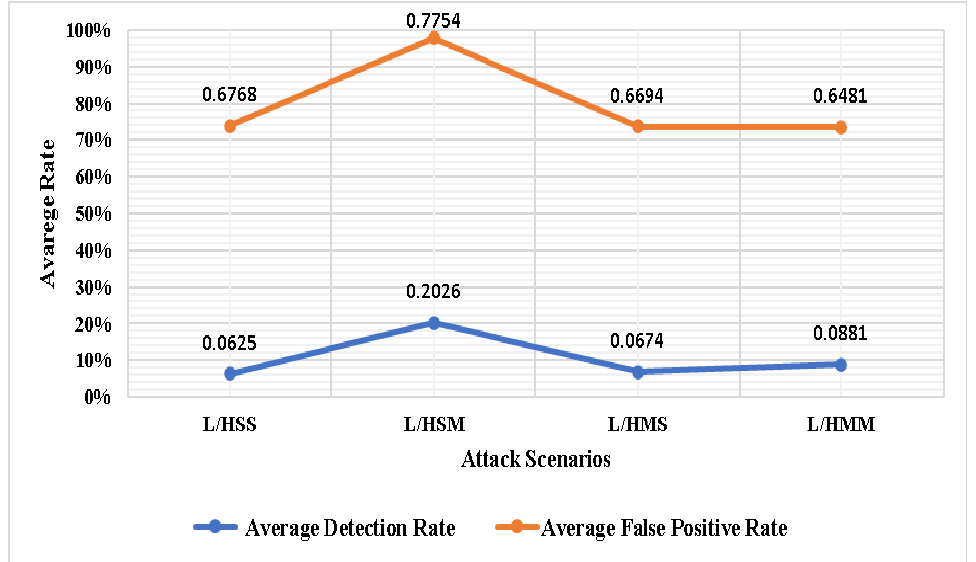
Figure 7. Enhancement of the proportion of detecting low-rate DDoS attacks to high-rate DDoS attacks by the entropy-based detection approach using simulation scenarios.